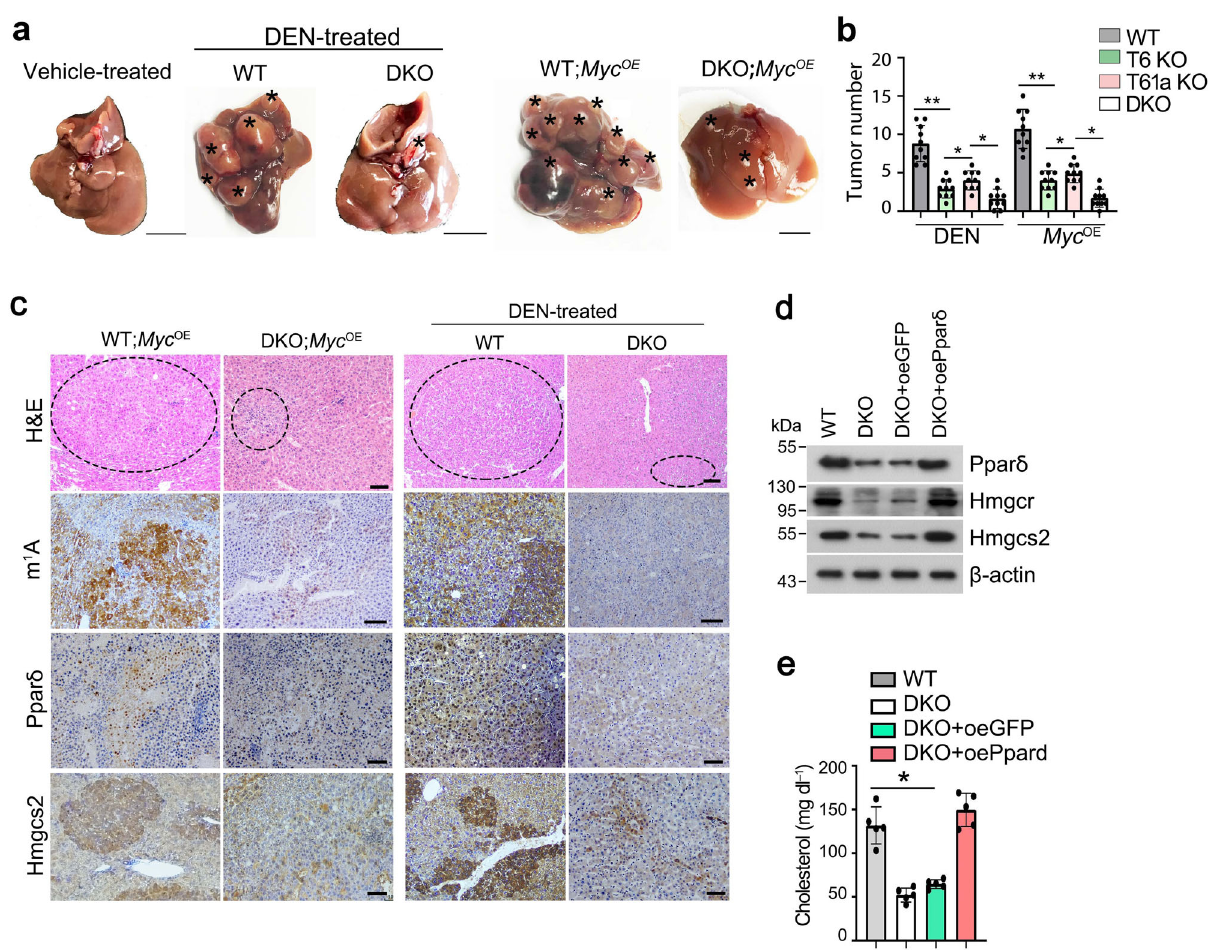
Fig. 6 Trmt6/Trmt61a knockout inhibits mouse cholesterol synthesis through Ppar δ pathway. a Macroscopic appearance of livers from Trmt6 f/ + /Trmt61a f/ + ; Alb-Cre (WT) and Trmt6/Trmt61a DKO ( Trmt6 f/f /Trmt61a f/f ; Alb-Cre) mice under DEN-induced cancer or in Myc OE mouse model of HCC. Black asterisks indicate liver tumors. Scale bar, 1 cm. b Quantitation of liver tumor numbers of Trmt6 KO, Trmt61a KO, and Trmt6/Trmt61a DKO in DEN- treated and in Myc OE mice. Results are shown as means ± SD ( n = 10 biologically independent mice). Exact P values from left to right: 0.0075, 0.041, 0.032, 0.0037, 0.045, 0.014. c Representative liver H&E staining and immunohistochemistry images of m 1 A, Ppar δ , and Hmgcs2 (brown) from Trmt6 f/ + /Trmt61a f/ + (WT) and Trmt6 − / − /Trmt61a − / − (DKO) in Myc OE and DEN-treated mice. Black circle indicates tumor region. Scale bar, 100 μ m. n = 3 independent samples. d Levels of cholesterol biogenesis related proteins in 10-week-old male Trmt6/Trmt61a deleted (DKO) in Myc OE mice transduced with AAV vectors encoding GFP control (oeGFP) or Ppar δ (oePpar δ ) for 8 days. WT: Trmt6 f/ + /Trmt61a f/ + ; Myc OE mice. n = 5 biologically independent mice. e Total serum cholesterol levels in 10-week-old normal-fed male Trmt6/Trmt61a deleted Myc OE (DKO) mice transduced with AAV vectors encoding GFP control (oeGFP) or Ppar δ (oePpar δ ) for 8 days. WT: Trmt6 f/ + /Trmt61a f/ + ; Myc OE mice. Data are means ± SD. n = 5 mice per group. Exact P values: 0.021. These experiments were repeated three times. * P < 0.05; ** P < 0.01 by two-tailed Student ’ s t -test.